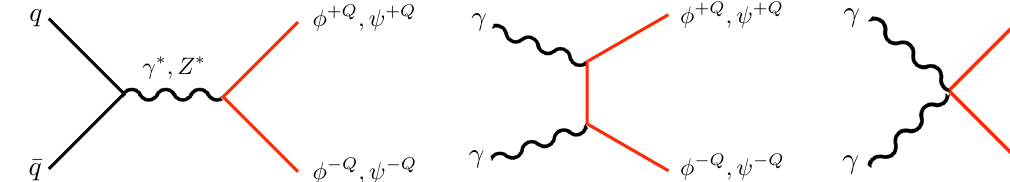
Fig. 1 Diagrams for colour-singlet open production modes